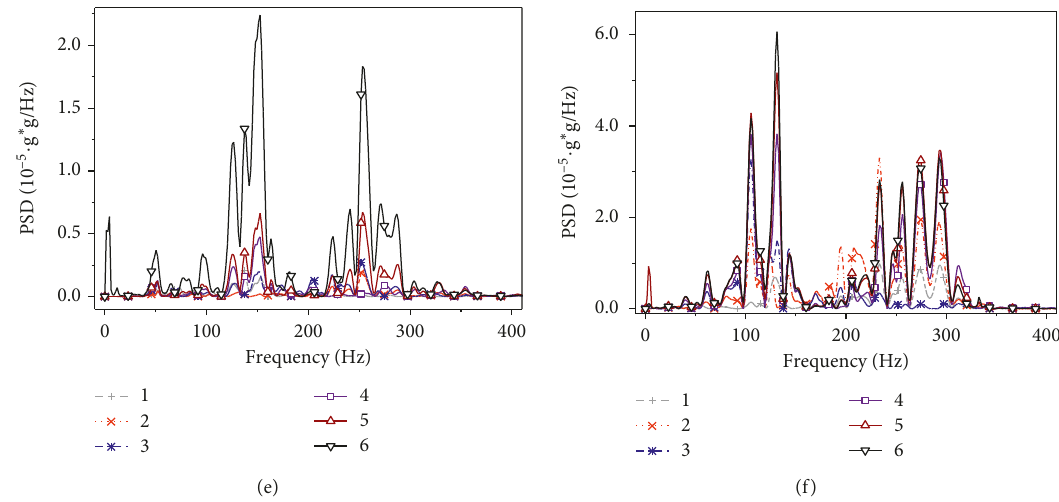
Figure 11: Track components PSD. (a) N-LVTrail: (left) full chart; (right) enlarged details of the PSD. (b) T-LVTrail: (left) full chart; (right) enlarged details of the PSD. (c) N-LVT bearing block. (d) T-LVT bearing block. (e) N-LVT track slab. (f) T-LVT track